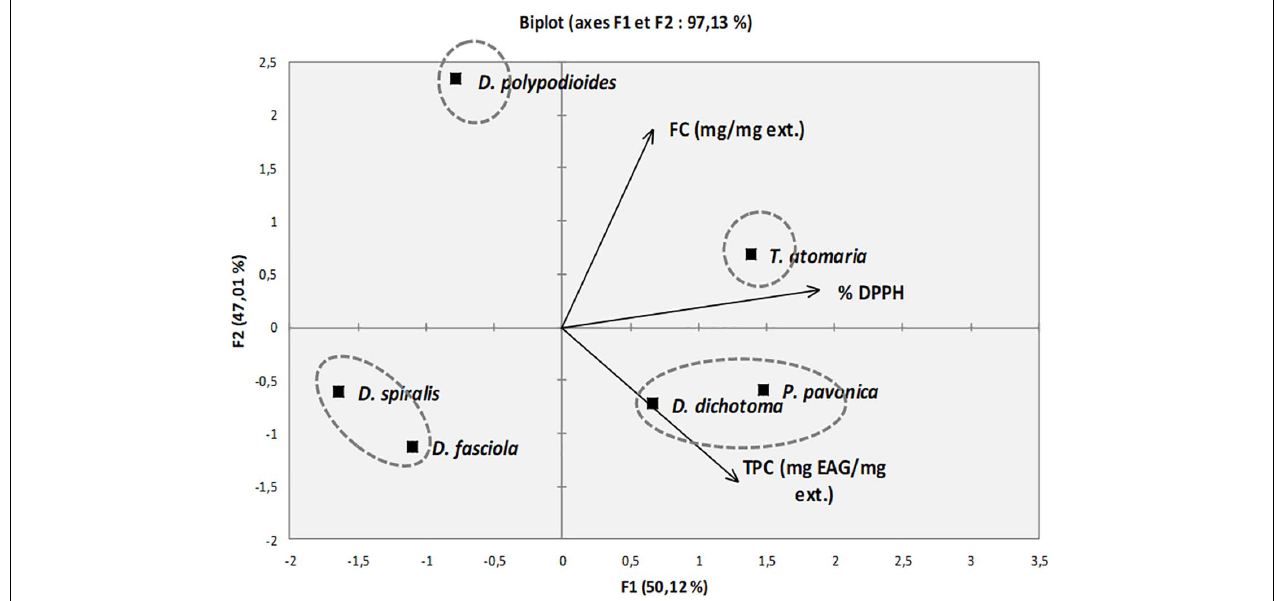
FIGURE 3 | Principal component analysis (PCA) of fucoxanthin content (FC), total phenolic content (TPC), and DPPH radical-scavenging capacity (%) of extracts. Each species is distributed according to its